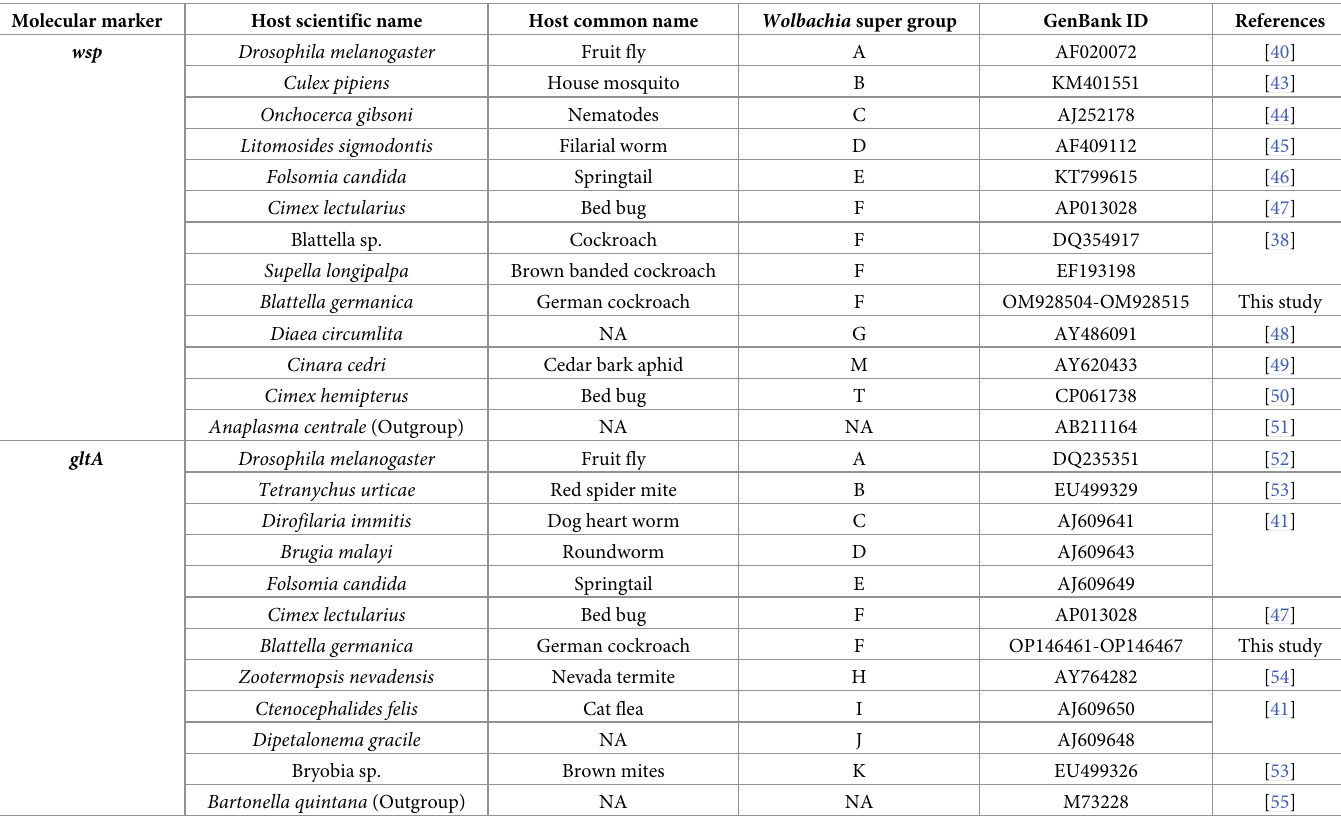
Table 2. Representative wsp and gltA Wolbachia type sequences used in this study. Molecular